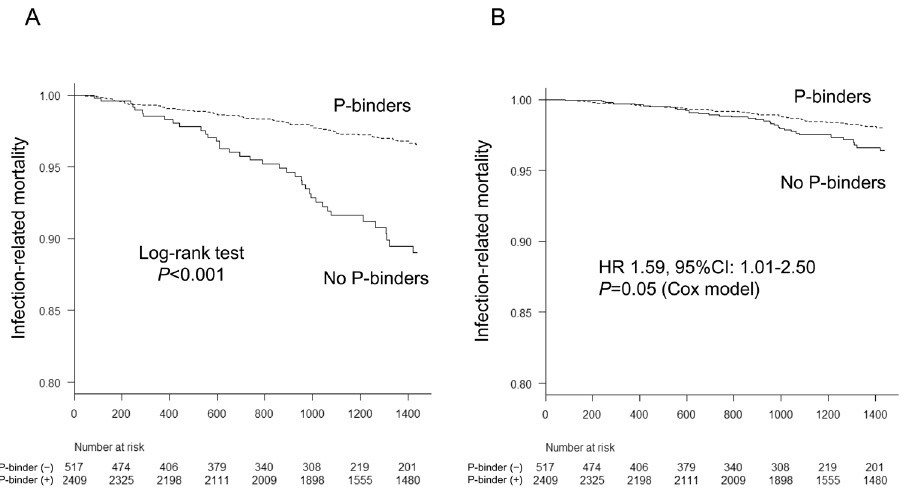
Figure 2. Kaplan-Meier analysis for the infection-related mortality between phosphate-binder users and non-users. ( A ) Non-adjusted curve. ( B ) Multivariable-adjusted curve. Log-rank test was used to compare the survival curve between the two groups in non-adjusted curve. Adjustment using Cox proportional hazard model was performed for baseline characteristics (age, sex, presence of diabetes mellitus and comorbidity, dialysis vintage, dialysis time per session, Kt/V for urea, normalized protein catabolic rate, body mass index, cardiothoracic ratio, systolic blood pressure, blood hemoglobin level, serum levels of urea nitrogen, creatinine, albumin, total cholesterol, C-reactive protein, corrected calcium, P, parathyroid hormone, alkaline phosphatase, and use of erythropoiesis stimulating agents, anti-hypertensives, and vitamin D receptor activators. The relative hazards risk and 95%Ci in patients without P-binders compared with those with P-binders were described in the figure. A two-tailed P -value < 0.05 was considered to be statistically significant. Abbreviations: CI, confidence interval; HR, hazard ratio; P, phosphate.